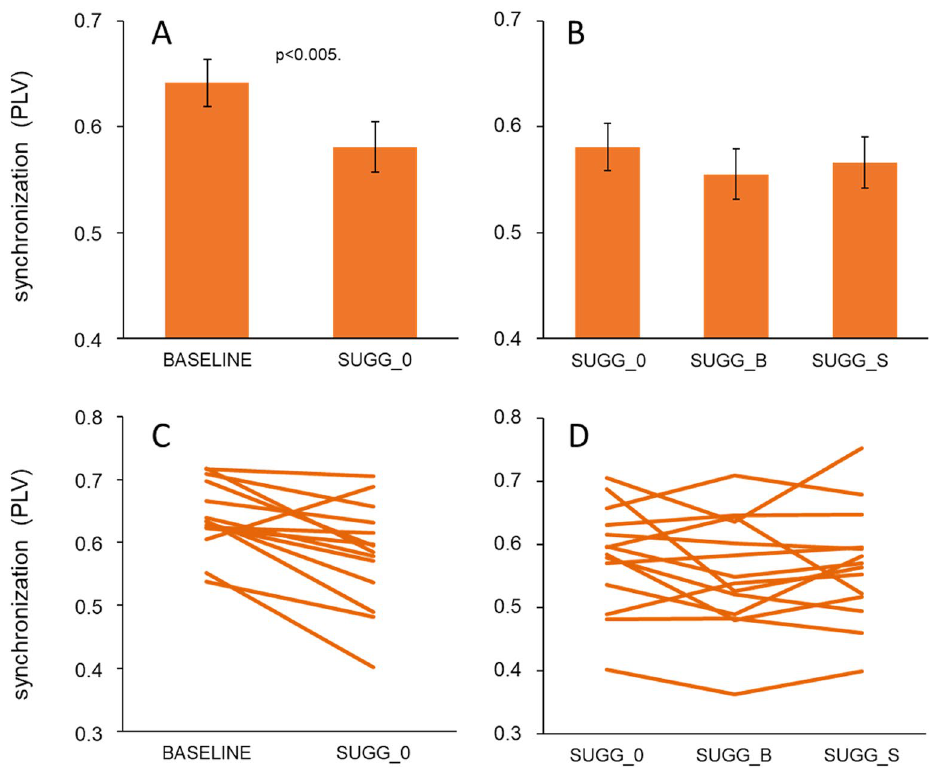
Figure 8. Resting-state functional connectivity for different hypnotic conditions. Phase-locking synchronization (PLV) ratios of the EEG beta (13–30 Hz) frequency band between left and right hemispheric medial frontal cortex (MFC) and the finger representation (CP3, CP4) in somatosensory cortex (SI). Mean synchronization after hypnosis without suggestion (SUGG_0) and baseline ( A ), and suggestions SUGG_0, SUGG_B and SUGG_S ( B ). ( C , D ) Individual changes of the PLV